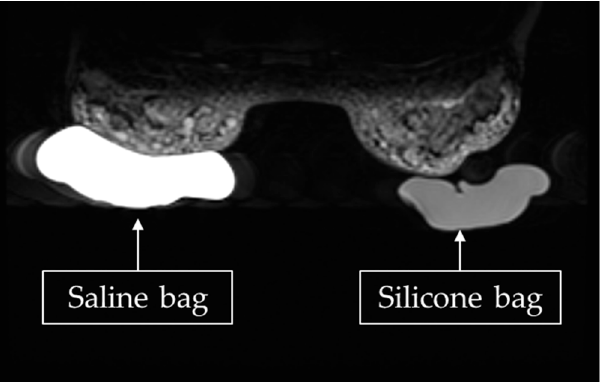
Figure 1. A magnetic resonance image comparing silicone-injected augmented breasts with a saline bag and a silicone bag, each placed under a breast.